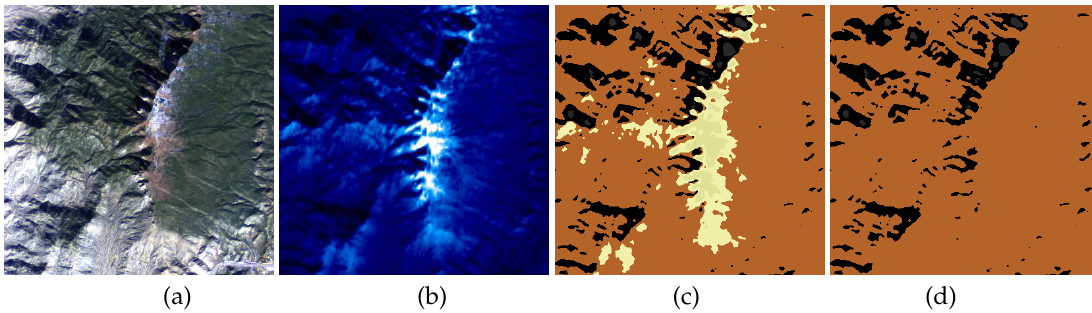
Figure 7. Sentinel-2 subset, Rocky Mountains near Albuquerque, 06/12/2015, ( a ) true color, ( b ) cirrus channel, ( c ) standard cirrus mask, ( d ) identical M1, M2 masks with no cirrus detected.